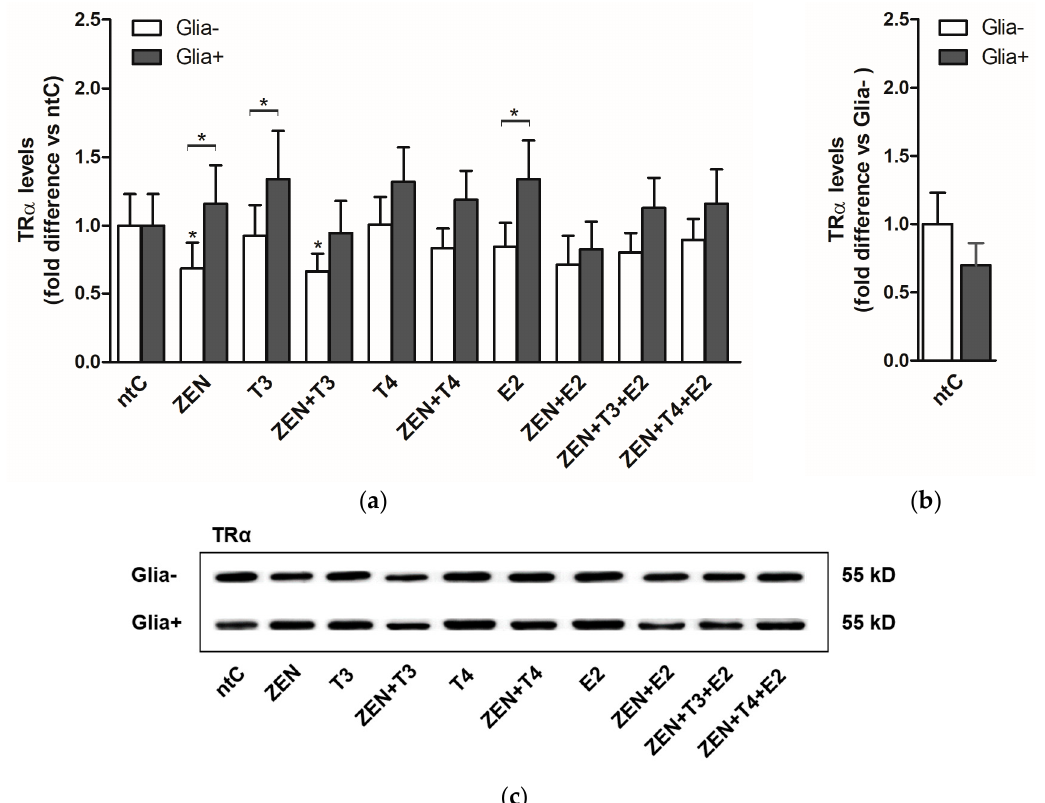
Figure 2. TR α protein expression levels in cerebellar granule cells in the absence, Glia − , or presence of glial cells, Glia+; treated with zearalenone (ZEN), and/or triiodo-thyronine (T3), thyroxine (T4) and 17 β -estradiol (E2) for 18 h, examined by Western blotting. ( a ) Shown P-values were calculated: compared to ntC (above and next to the bars) and Glia+ compared to Glia − (*) p < 0.05 (above braces) in each treatment group. ( b ) Expression of TR α protein in non-treated controls normalized to Glia − ( p -value not shown). All data represents the mean ± SD of at least three independent experiments ( n = 6 per treatment). ( c ) Representative Western blot images.